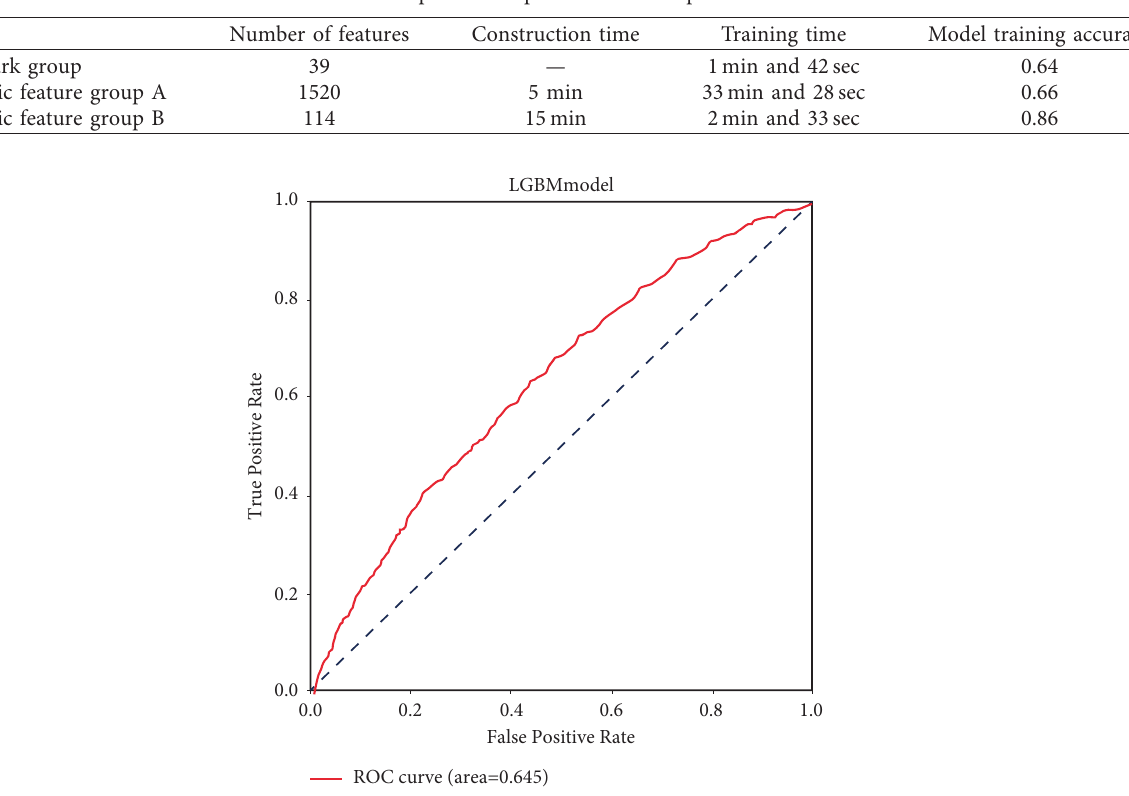
Figure 4: ROC curve of the benchmark